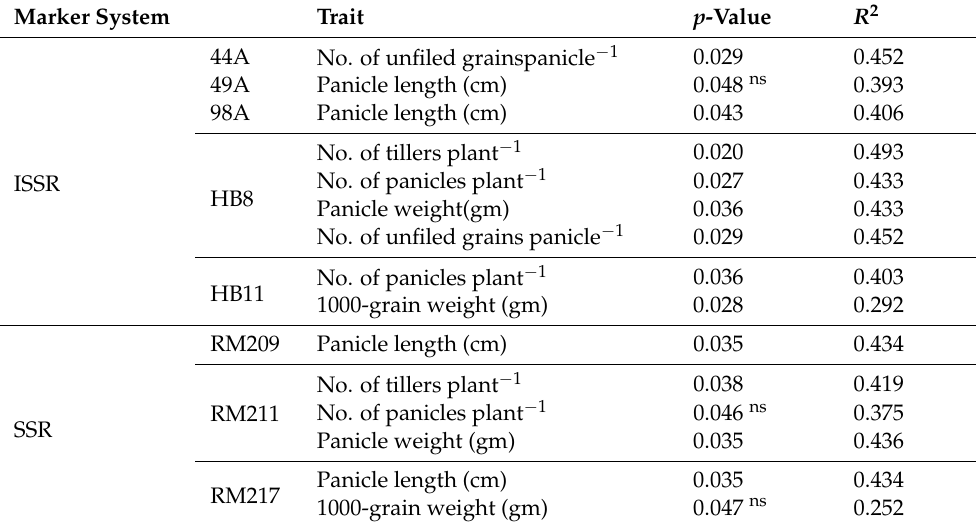
Table 8. Association between ISSR and SSR markers and agro-morphological traits in 12 rice geno- types showing the marker, significance level ( p ), and its attributable percent of phenotypic variance ( R 2 ). Listed associations were considered significant at p ≤ 0.05 and were verified by using the false discovery rate